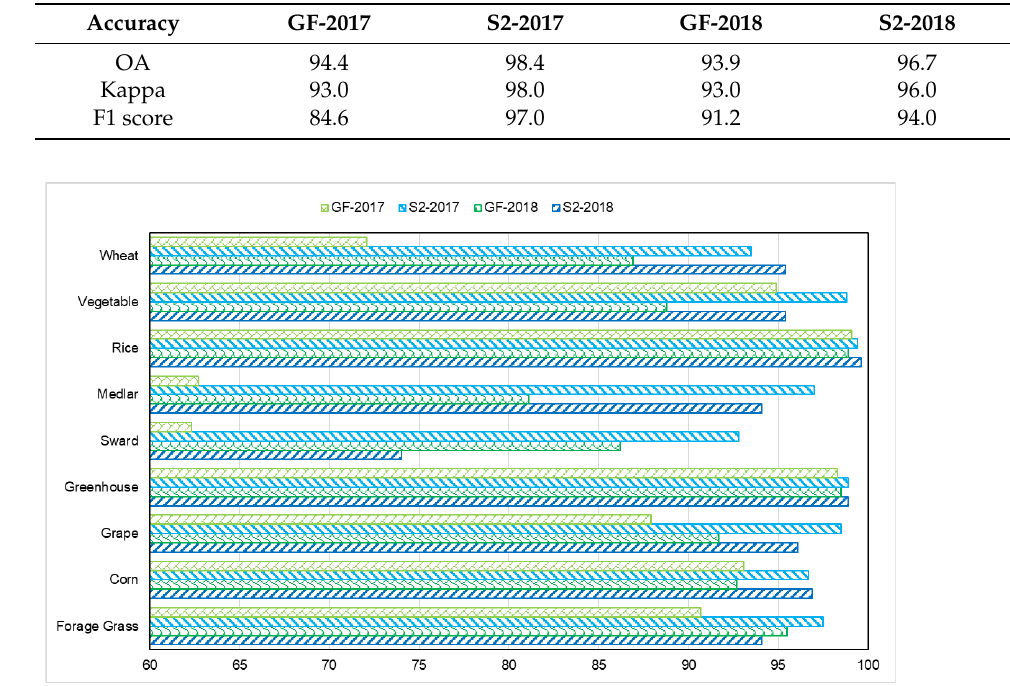
Figure 6. The accuracy of F1 score for each crop type from GF-1 and S-2 for the two years.